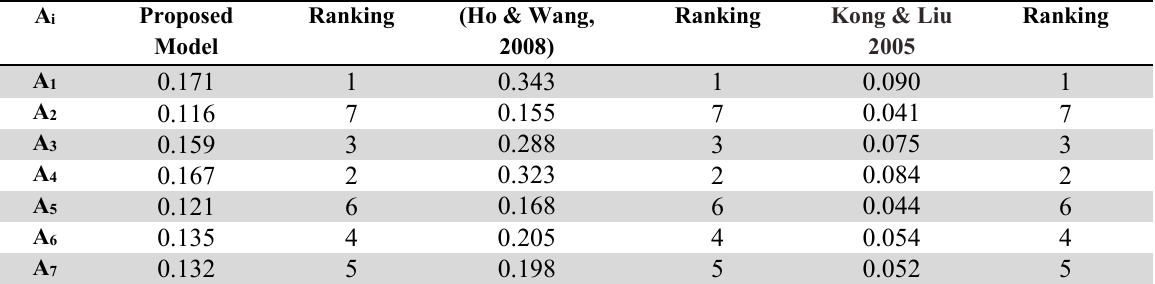
Comparison of the extended fuzzy AHP and the traditional Fuzzy